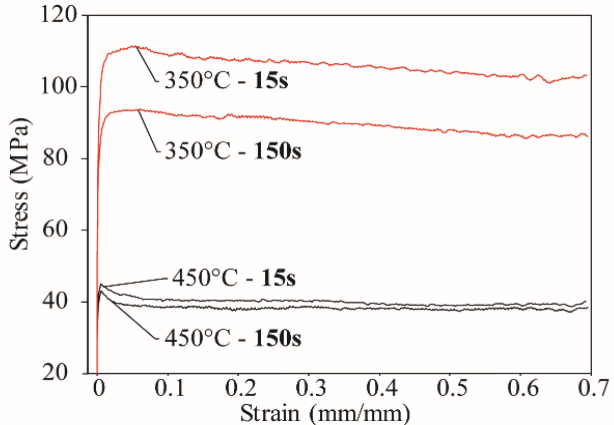
Figure 7. Data illustrating the effects of isothermal hold time on the flow curves for MMC 5F when deformed at 350 °C and 450 °C. A strain rate of 0.05 s −1 was employed in all instances.